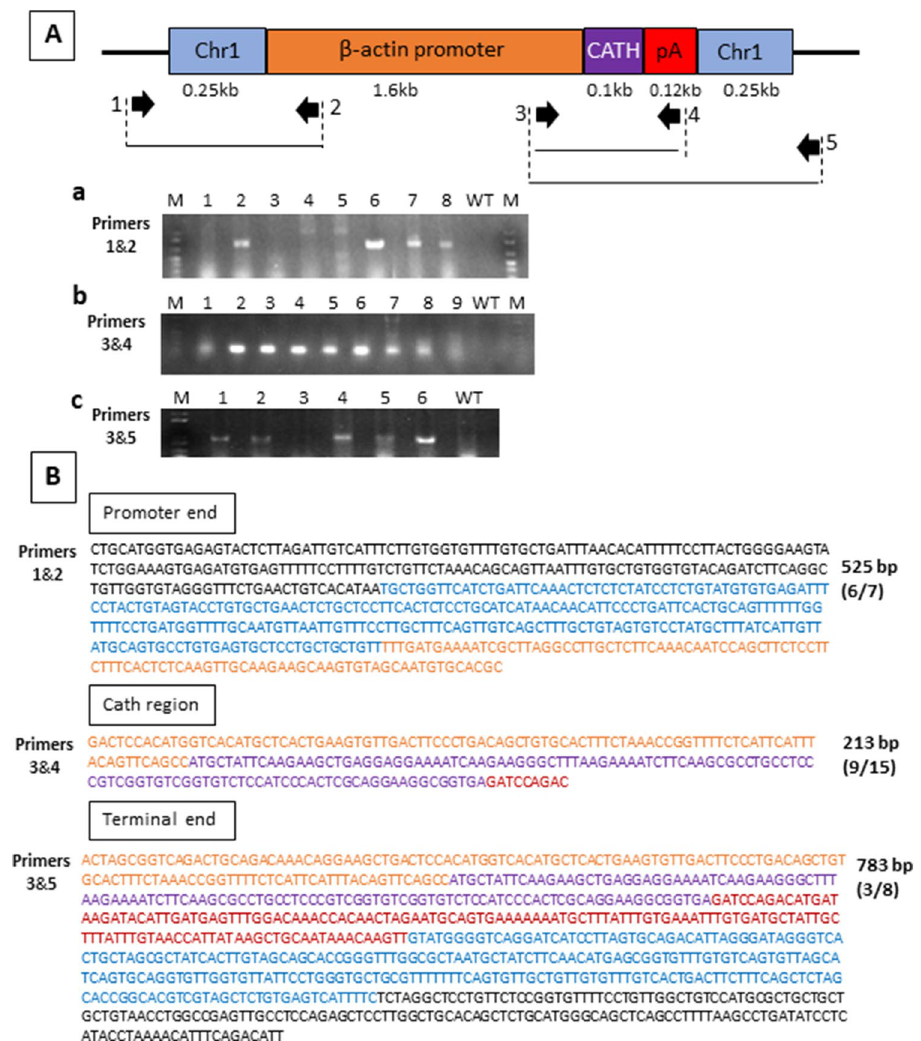
Figure 4. Genotyping strategy for CRISPR/Cas9 knock-in of channel catfish ( Ictalurus punctatus ) using dsDNA construct driven by β-actin promoter carrying the alligator cathelicidin gene (dsDNA-BA-Cath). ( A ) Schematic diagram of dsDNA-BA-Cath construct. (a, c) PCR amplification of primer sets at the 5 ′ and 3 ′ junctional regions (primer sets 1&2 and 3&5) and (b) the insert-specific region for alligator cathelicidin gene (primer set 3&4). Numbers in a lane represent individual samples of fish, lane WT represent wild type channel catfish and lane M indicates DNA marker. Presence of a distinct band indicates positive for transgene. Gel electrophoresis images shown here are cropped; full-length gels are presented in Supplementary Figure S2. ( B ) Representative sequences derived from channel catfish positive for integration of dsDNA-BA-Cath construct. Sequences in black are the regions outside of homologous arms; Blue sequences are the homologous arms that are part of the transgene construct; Green are partial sequences from the zebrafish ubiquitin promoter region; Purple are the sequences of the alligator cathelicidin gene. Red sequences belong to the poly A terminator sequence. Numbers on the right side of each sequence indicate the number of base pairs in the promoter region, alligator cathelicidin gene region and terminal region as revealed by sequencing of positive fish. Numbers in parentheses are the number of sequencing reactions which yielded positive transgene integration over the total number of sequencing